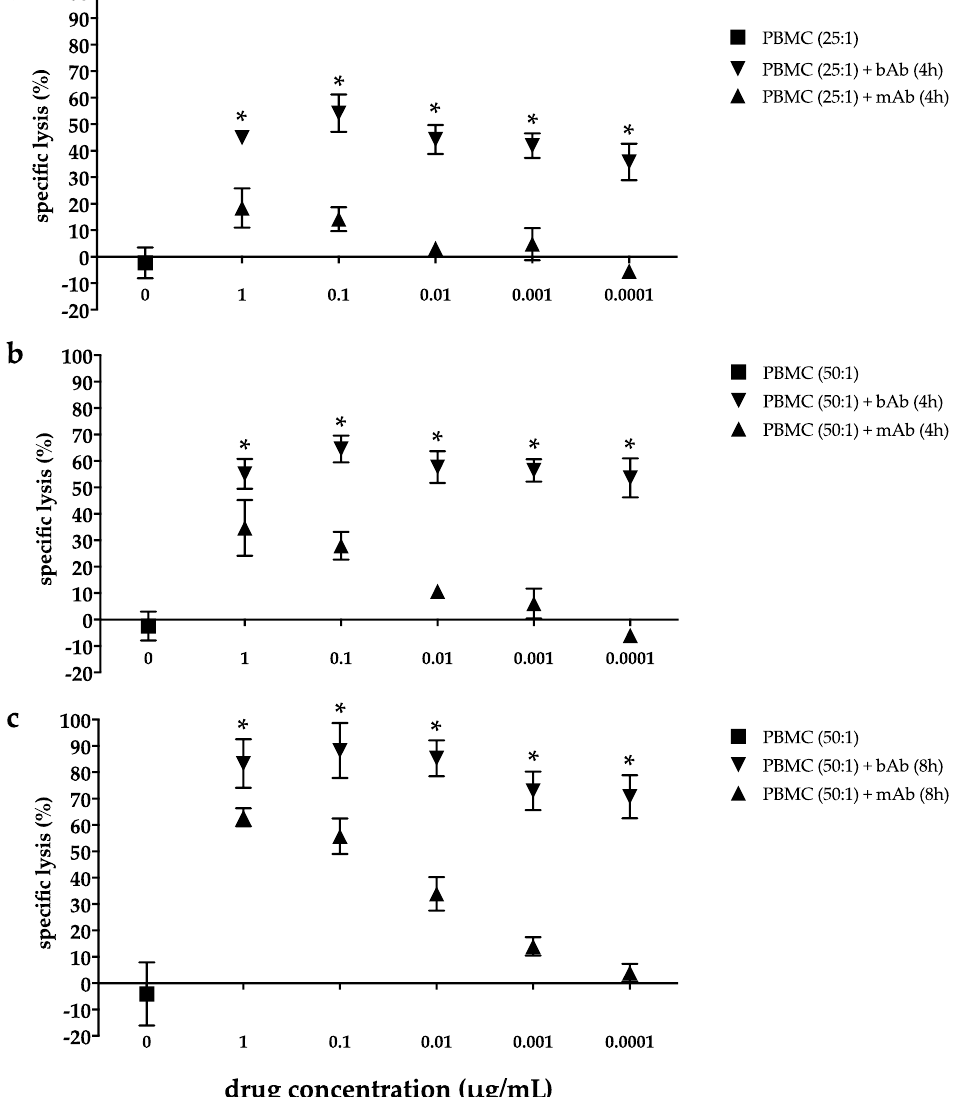
Figure 2. EpCAM/CD3-bispecific antibody mediates time-dependent strong cytotoxicity with stable activity at decreasing drug concentrations in the embryonal carcinoma cell line 2102Ep . 2102Ep cells were incubated for 4 h ( a , b ) or 8 h ( c ) with peripheral blood mononuclear cells (PBMC) at an effector:target cell ratio of 25:1 ( a ) or 50:1 ( b , c ) and stated concentrations of the monoclonal EpCAM-Ab Vu1D9 (mAB) or the bispecific trifunctional EpCAM/CD3-Ab Catumaxomab (bAb). Antibody-dependent cytotoxicity was assessed by europium release assay in triplicates and expressed in percentage of dead cells. Data are presented as mean ± SD of 2–3 independent experiments. Statistically significant difference between mAb- and bAb-mediated cell death is marked by an asterisk (* p < 0.001). PBMC alone had no cytotoxic e ff ect on 2102Ep cells. In contrast, at an e ff ector-to-target (E:T) ratio of 25:1, bAb-induced tumor cell lysis is 44.9 ± 2.5% at 1 µ g / mL and 44.2 ± 5.4% at 0.01 µ g /